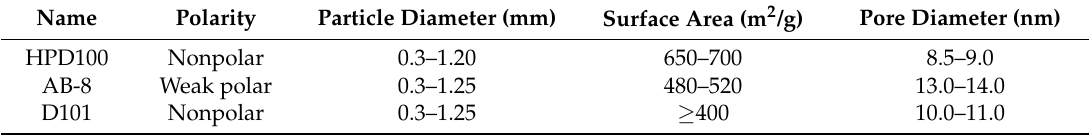
Table 5. Result of adsorption and desorption capacities of different macroporous